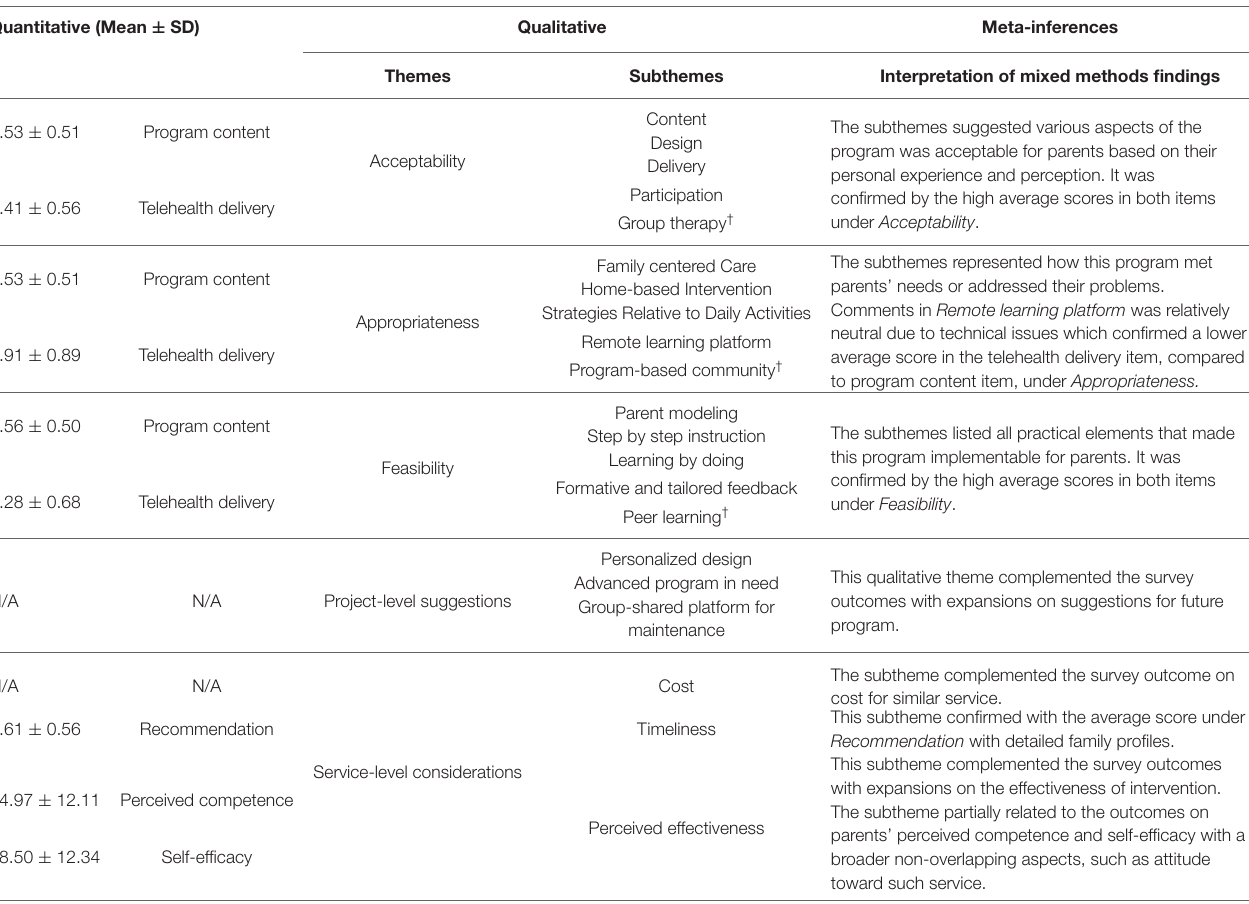
TABLE 6 | Joint display of the quantitative and qualitative findings with